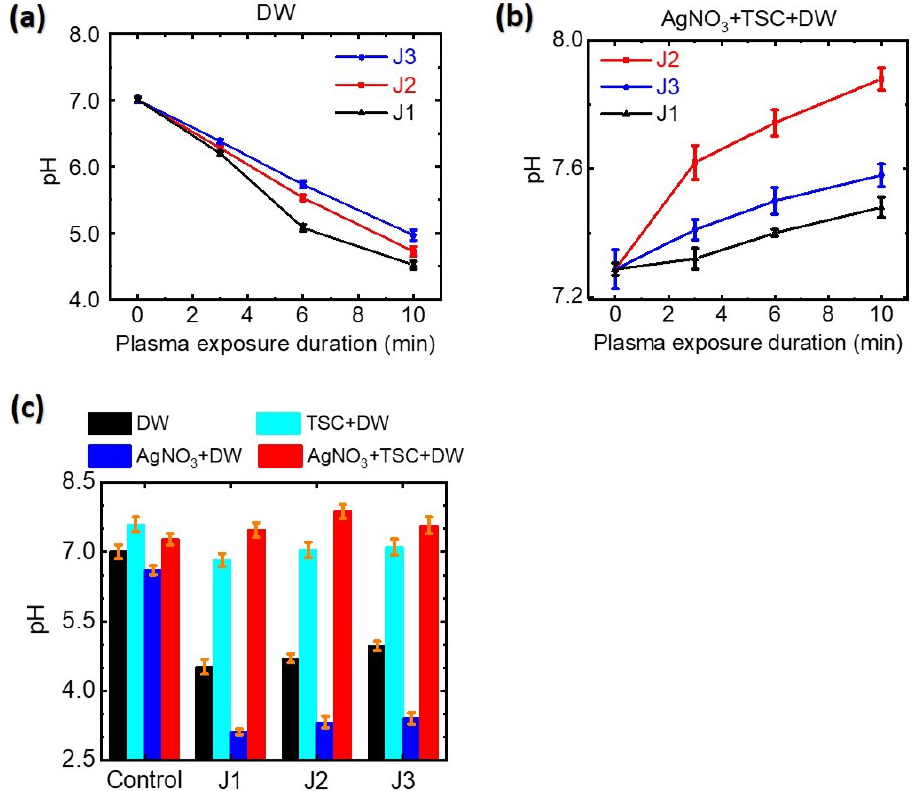
Figure 7. pH values of ( a ) plasma-treated-DW and ( b ) plasma-treated AgNO 3 -TSC-DW as a function of plasma exposure duration. ( c ) pH values of DW, TSC-DW, AgNO 3 -DW, and AgNO 3 -TSC-DW treated for 10 min with the J1, J2, and J3